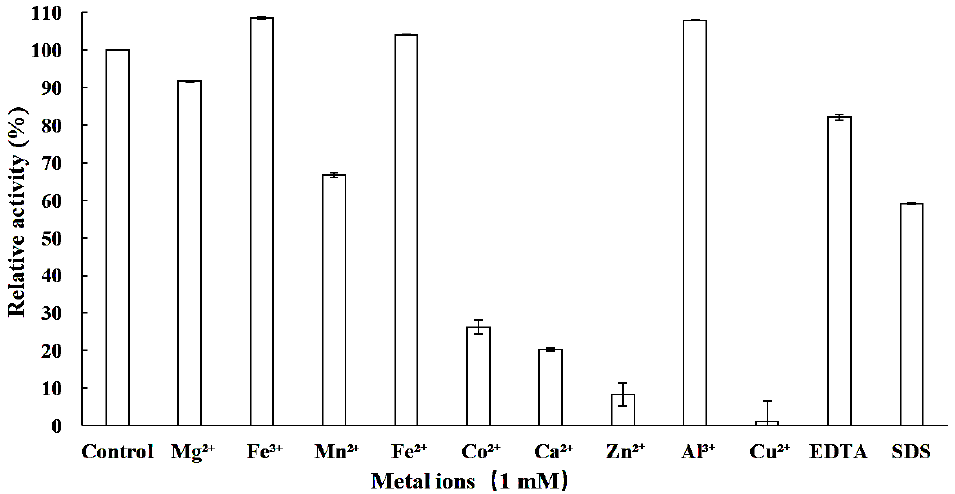
Figure 4. E ff ect of various metal ions on the β -D-fructofuranosidase of LcFFase1s. Figure 4. Effect of various metal ions on the β -D-fructofuranosidase of